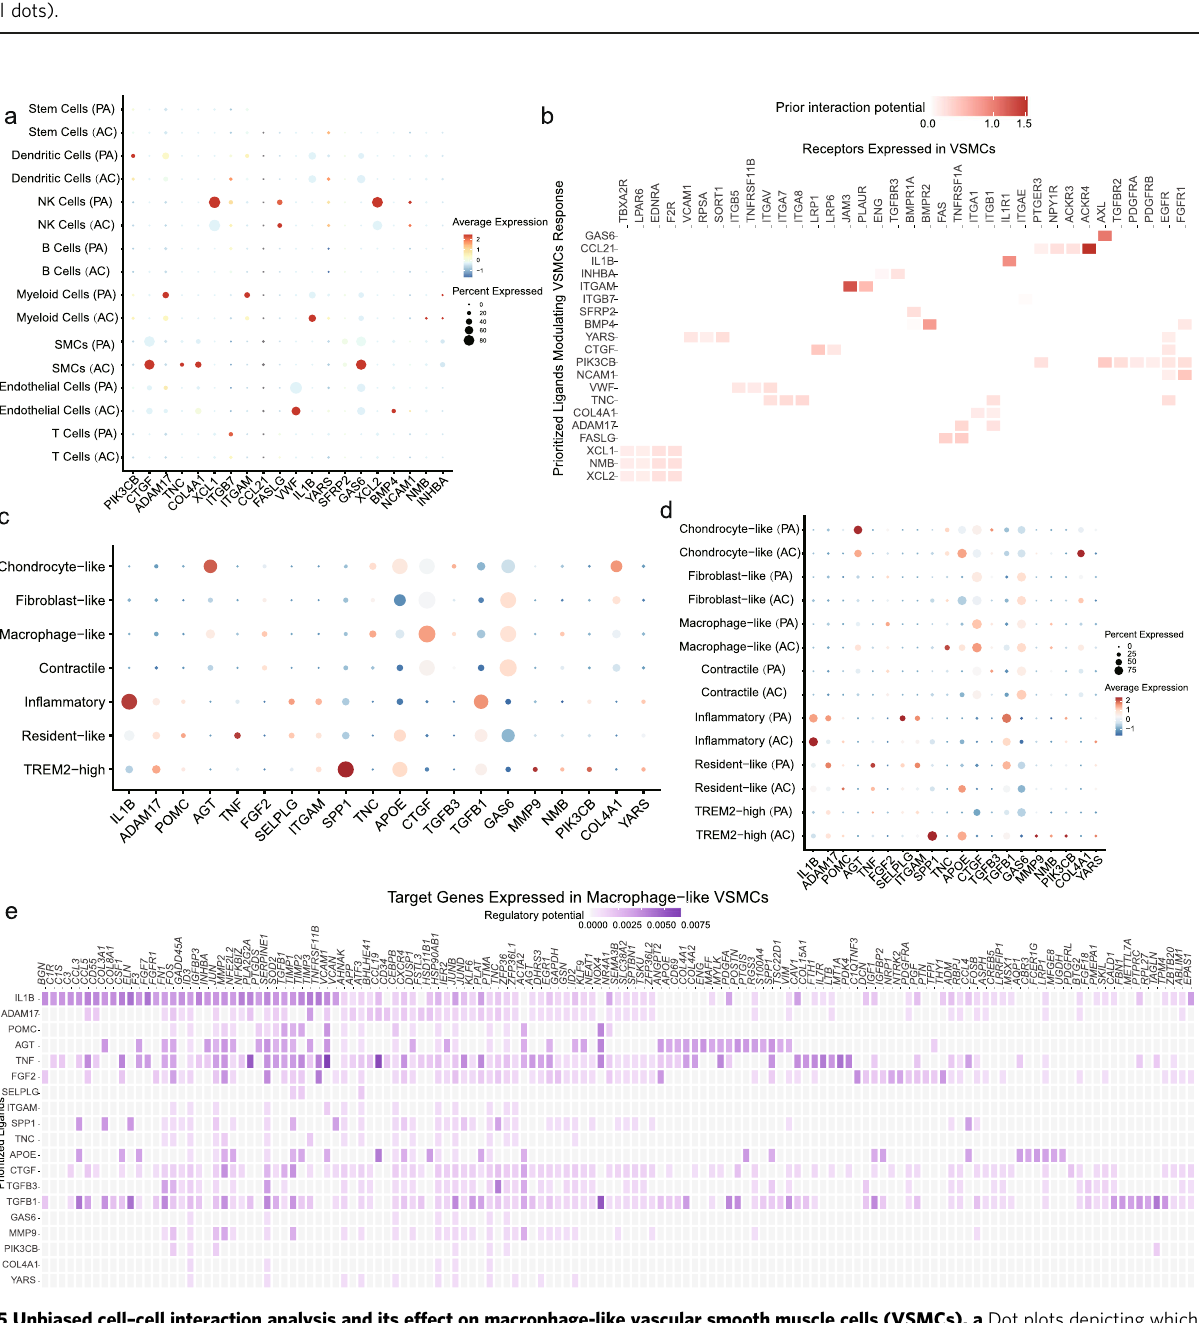
Fig. 5 Unbiased cell – cell interaction analysis and its effect on macrophage-like vascular smooth muscle cells (VSMCs). a Dot plots depicting which cell populations express top-ranked ligands contributing to the transcriptional response in VSMCs split by proximal adjacent (PA) and atherosclerotic core (AC) group. b Ligand-receptor heatmap of potential receptors expressed by VSMCs in cell crosstalk. c Dot plots of top-ranked ligand expressed in VSMC and myeloid cell subtypes contributing to the transcriptional response in macrophage-like VSMCs. d Dot plots of top-ranked ligand activities effecting contributing to the transcriptional response in macrophage-like VSMCs split by different group. e Ligand-target heatmap of macrophage-like VSMCs target genes of the identi fi ed Myeloid